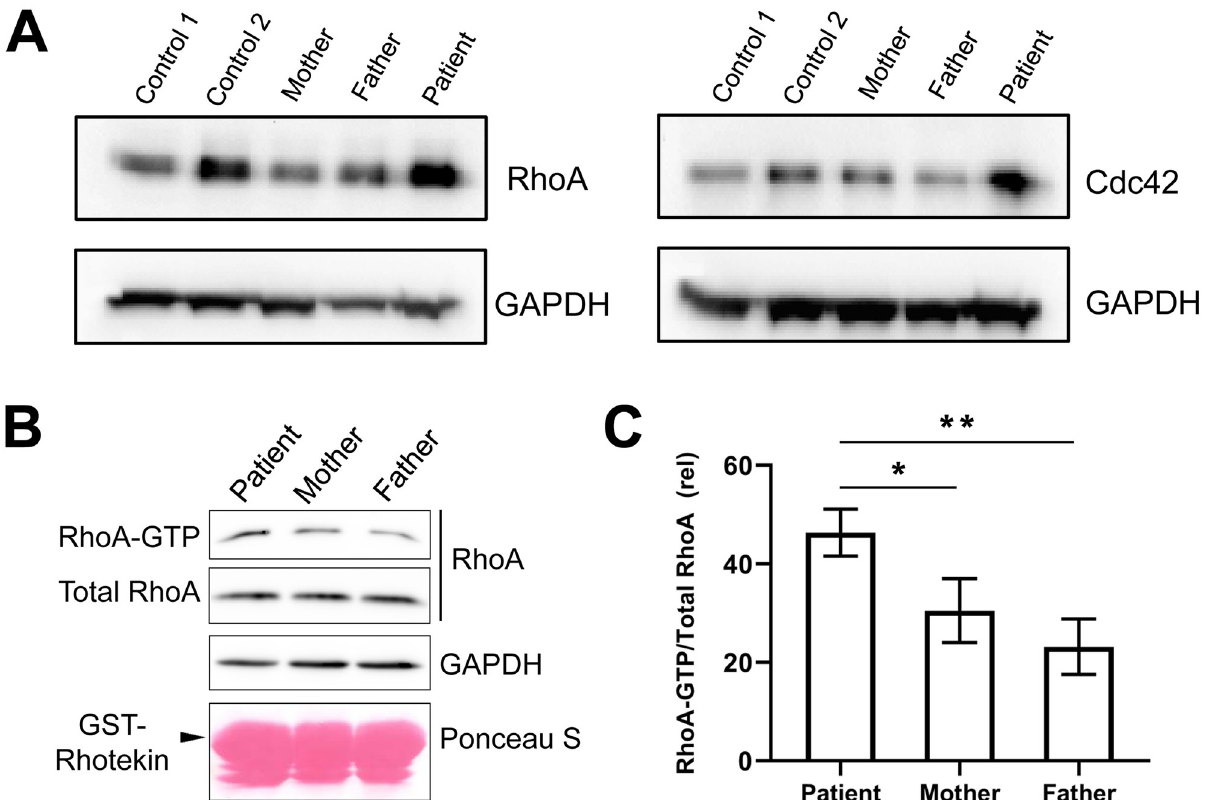
Fig 5. ARHGAP42 stop-gain variant contributes to enhanced RhoA activity and Cdc42 expression. (A) Expression of RhoA and Cdc42 in the patient’s EBV-LCLs compared with her parents and healthy controls by immunoblotting; (B) Measurement of RhoA activity by GST-Rhotekin-RBD (Rho binding domain) pull-down assay in the patient and her parents. The level of RhoA-GTP was determined by western blot with anti-RhoA antibody following a pull-down assay; (C) The RhoA-GTP data are expressed as the mean ± SD of three independent experiments. � p < 0.05; �� p <